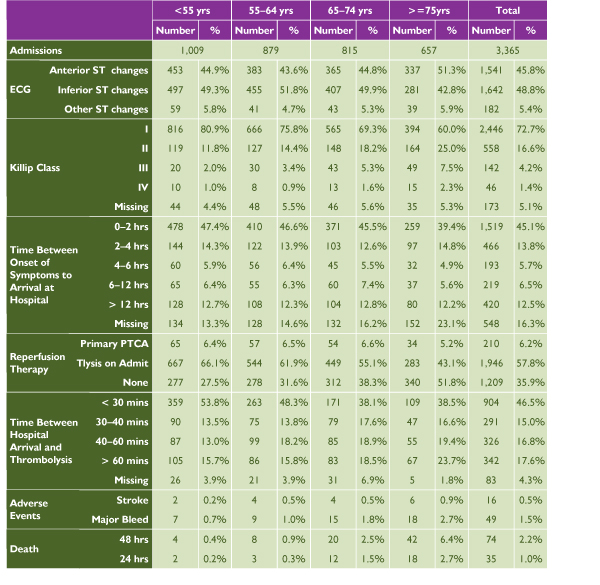
Use of Reperfusion Therapy in Men with ST Elevation Acute Myocardial Infarction in Canada, January 1, 2001 to December 31, 2001. Source: FASTRAK®11 Clinical Registry, 2001